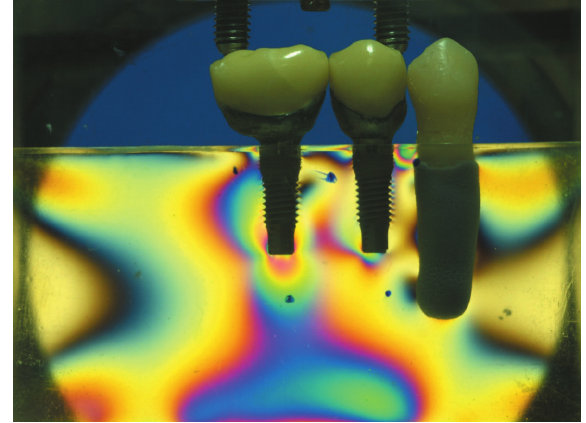
Figure 6- Vertical single point load (5 kgf) on the second premolar (model with the second molar replica)